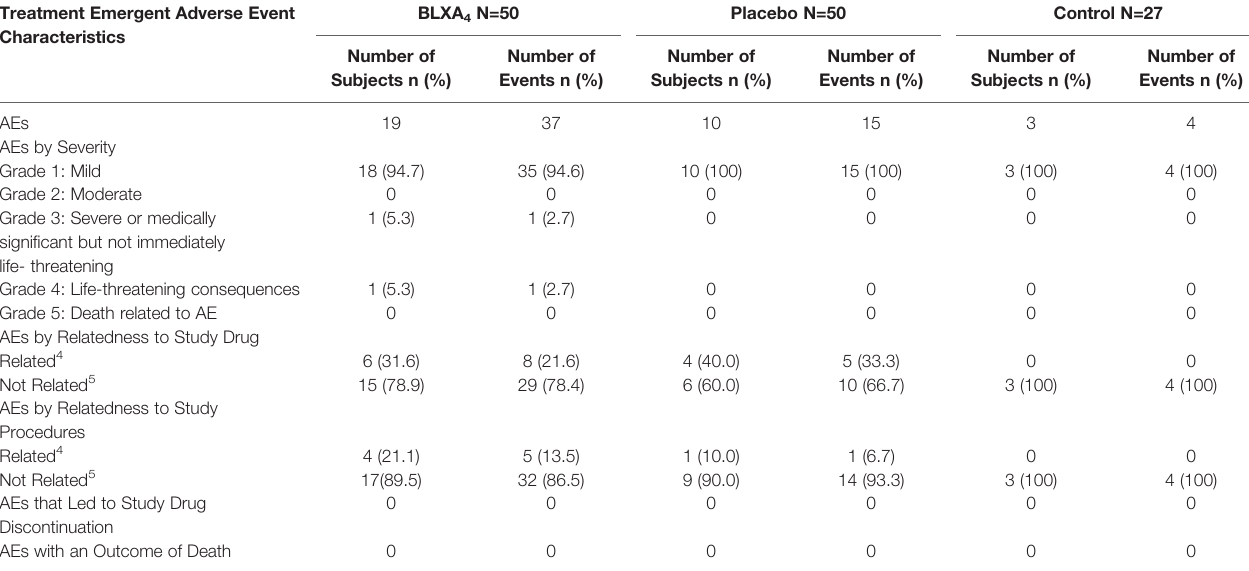
TABLE 3 | Primary endpoint, safety: summary of treatment emergent adverse event and event characteristics by study arm. Treatment Emergent Adverse Event